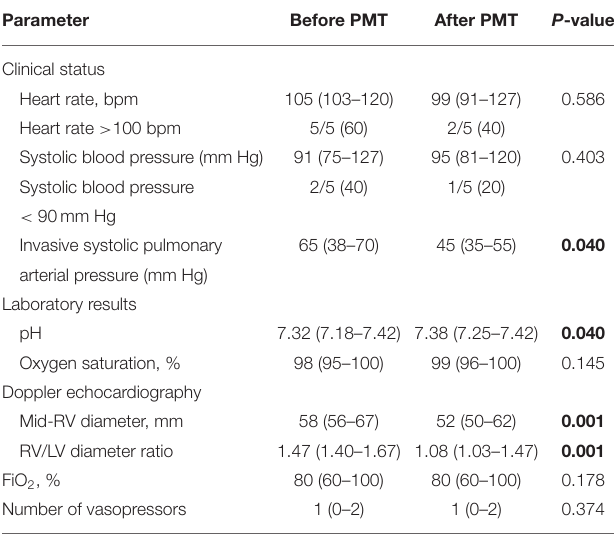
TABLE 4 | Hemodynamic parameters before and after percutaneous mechanical thrombectomy ( n = 5). Parameter Before PMT